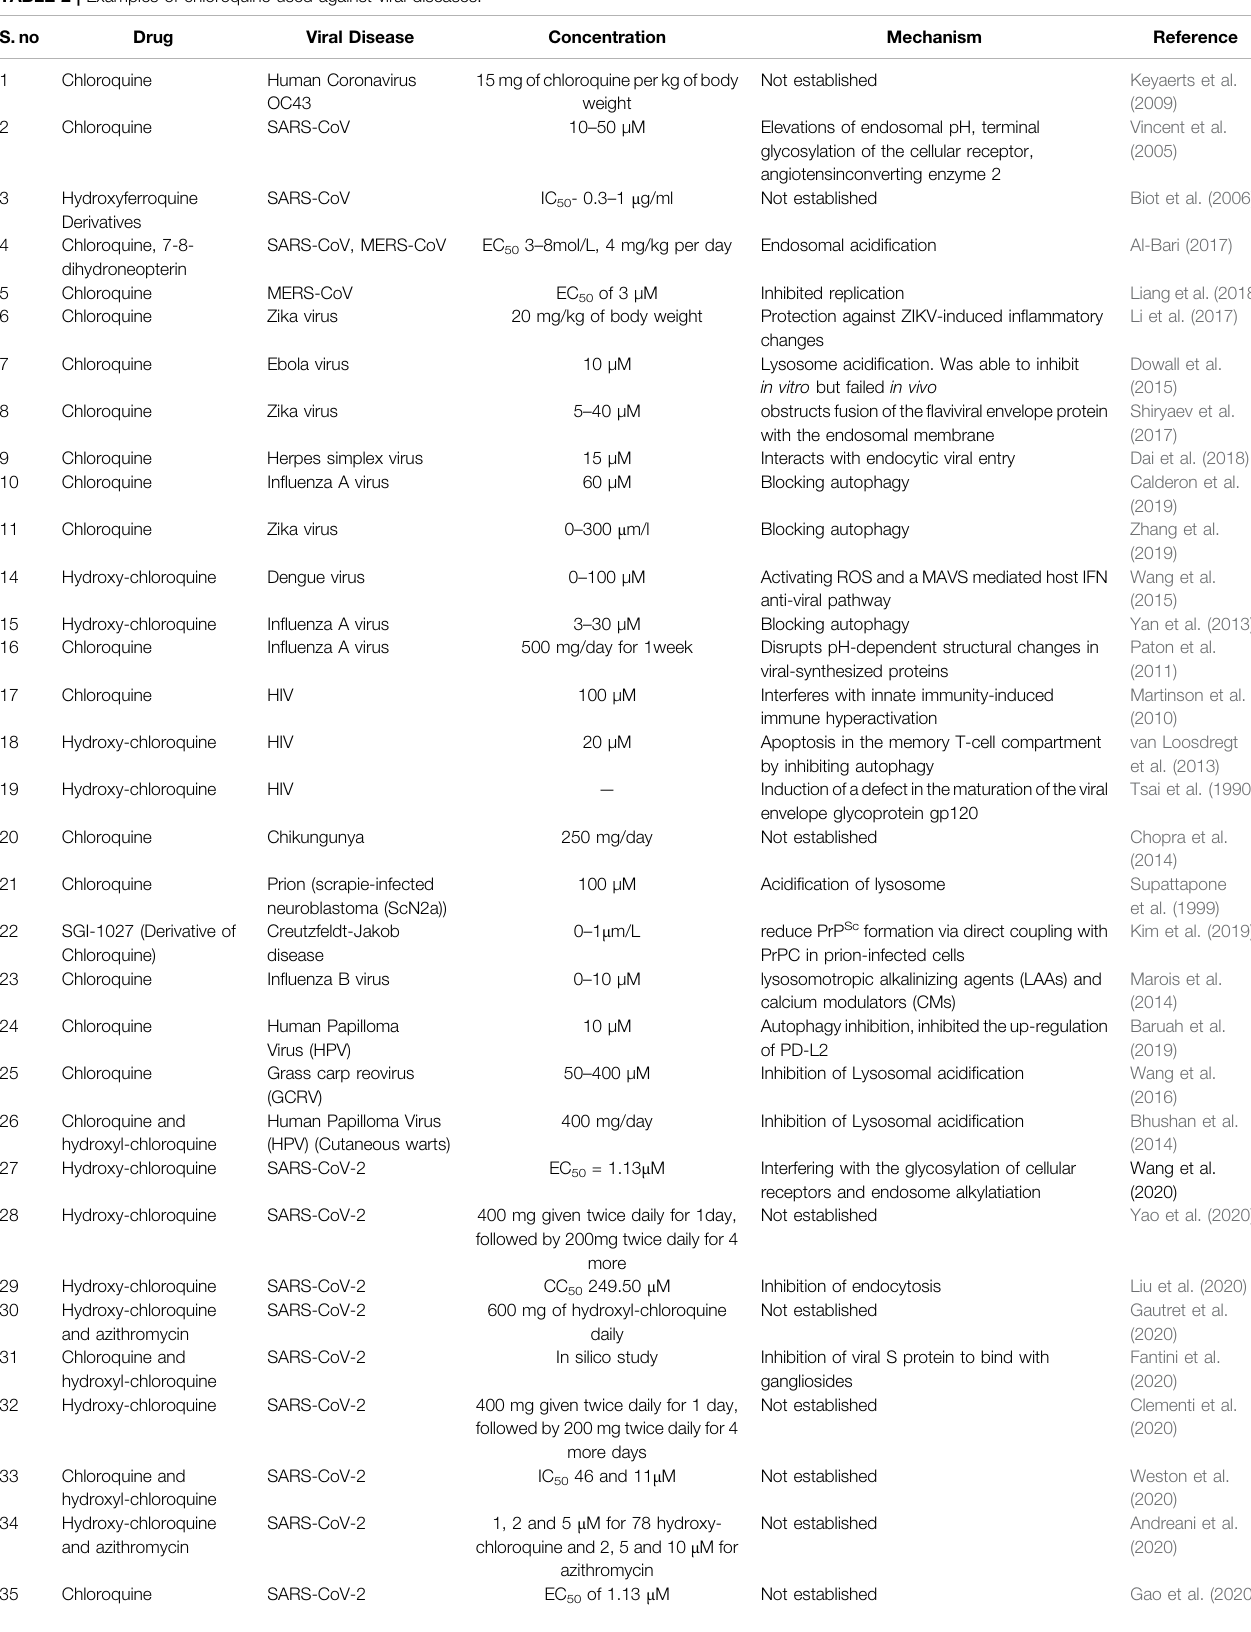
TABLE 2 | Examples of chloroquine used against viral